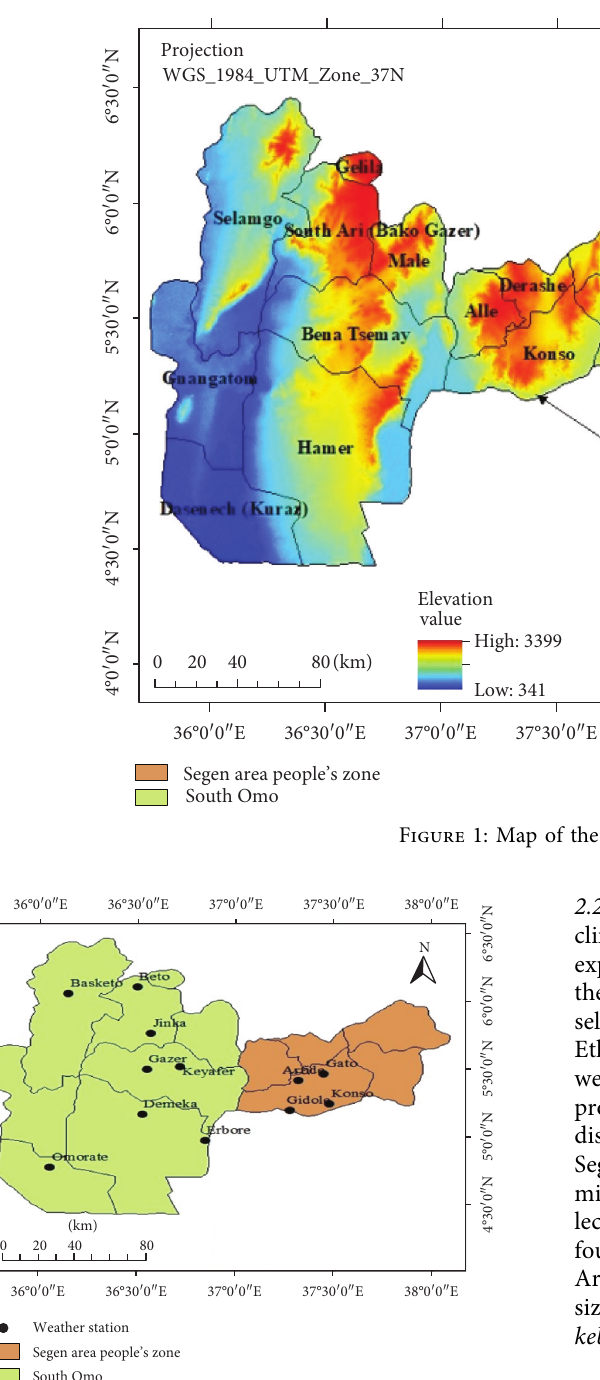
Figure 2: Spatial distribution of weather stations found in the study